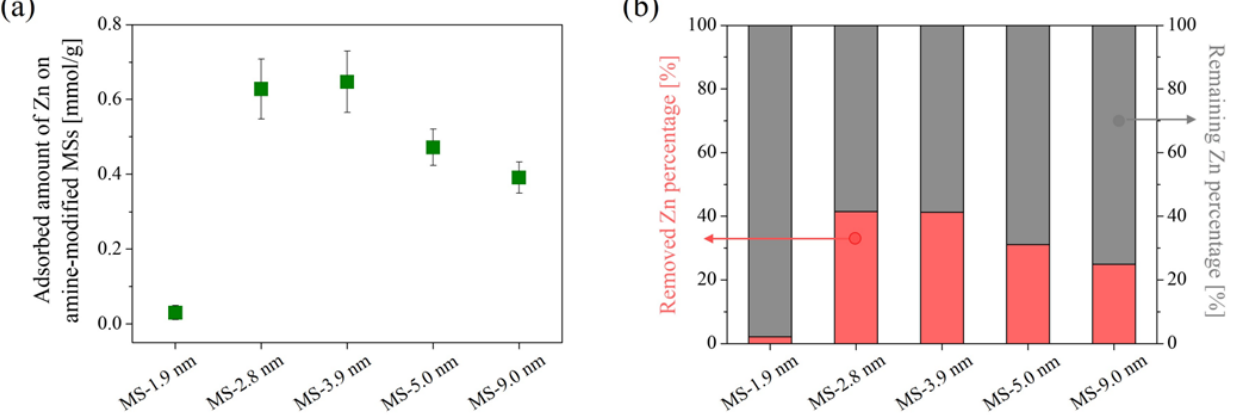
Figure 5. Zn adsorption amount on amine-modified MS with different initial MS pore sizes in single-component system ( a ) and their removed/remaining Zn percentage ( b ). Error bars indicate the standard deviation (± σ ).